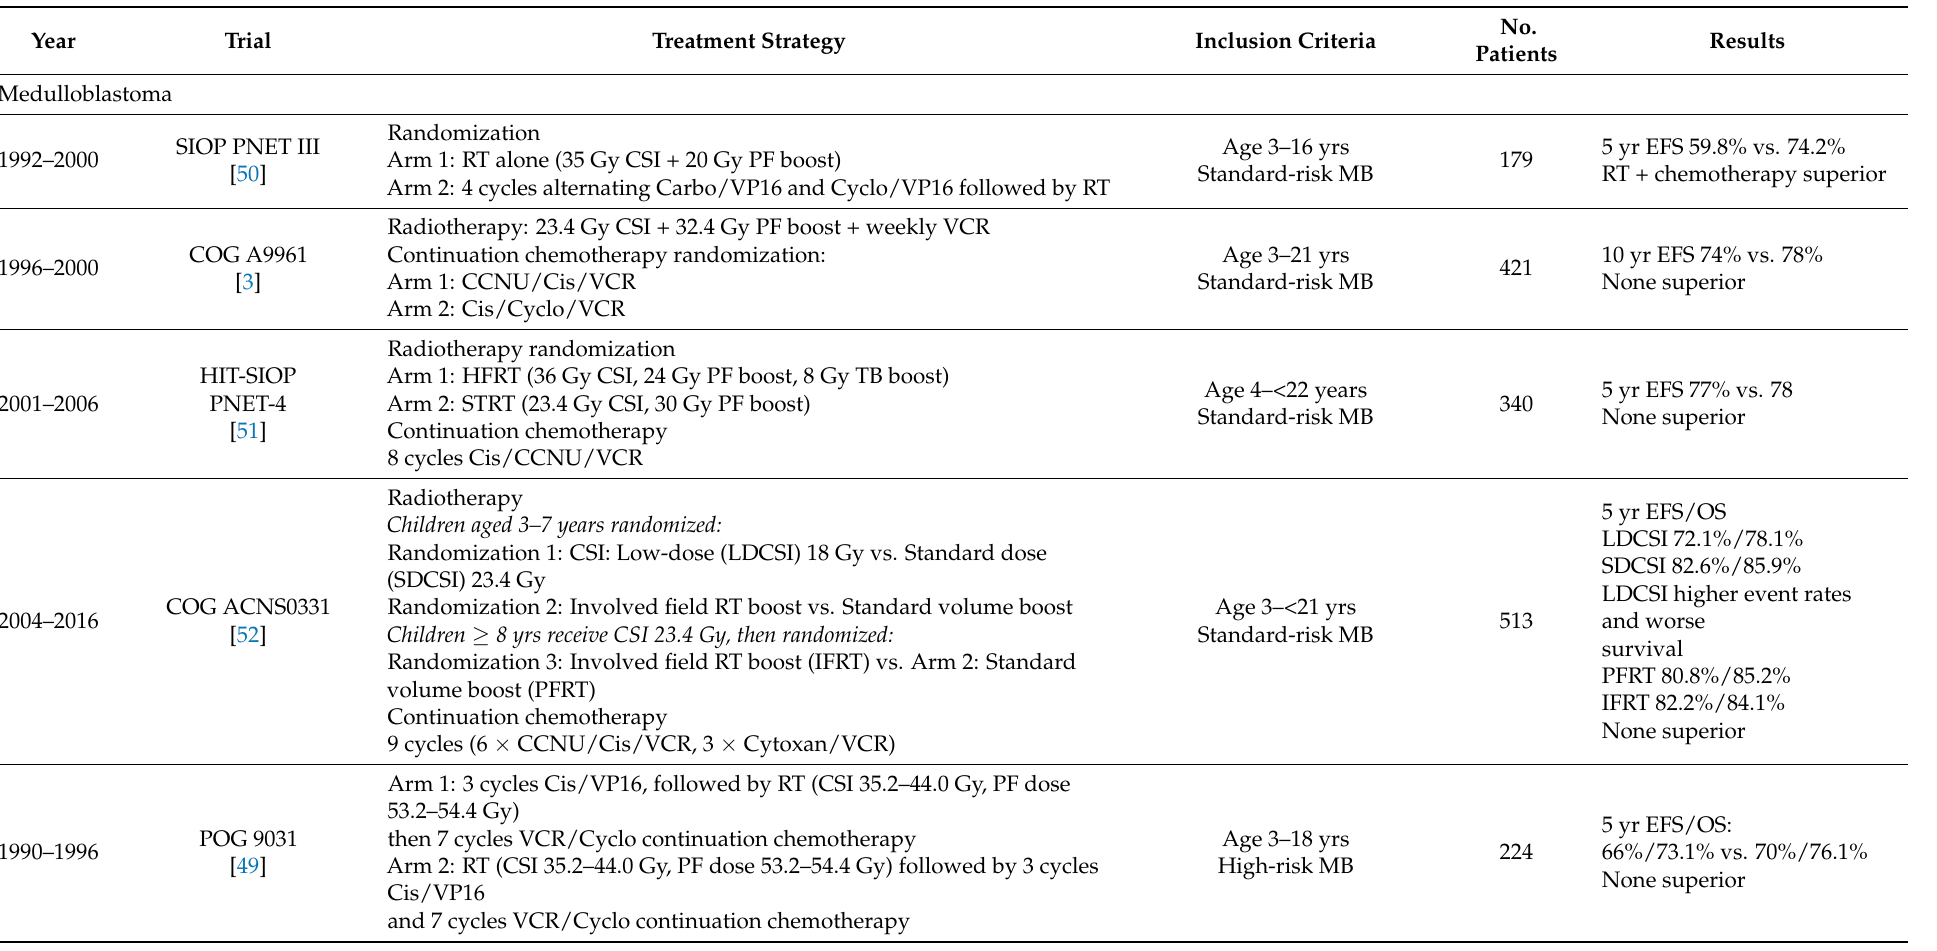
Table 1. Multinational collaborative clinical trials in pediatric medulloblastoma, high-grade gliomas and ependymoma, published since 2000. Treatment Strategy Inclusion Criteria